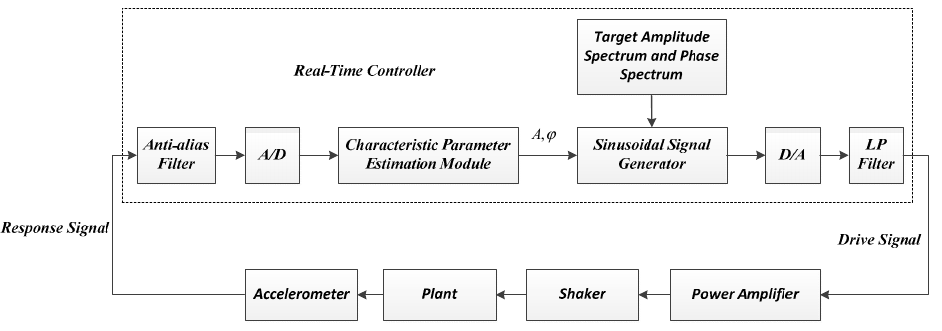
Figure 1. The control schematic for producing narrow-band excitation.